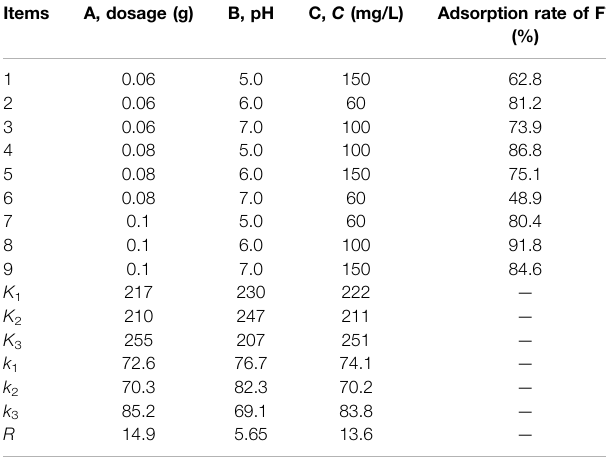
TABLE 3 | Orthogonal experimental results for F - adsorption on DA.